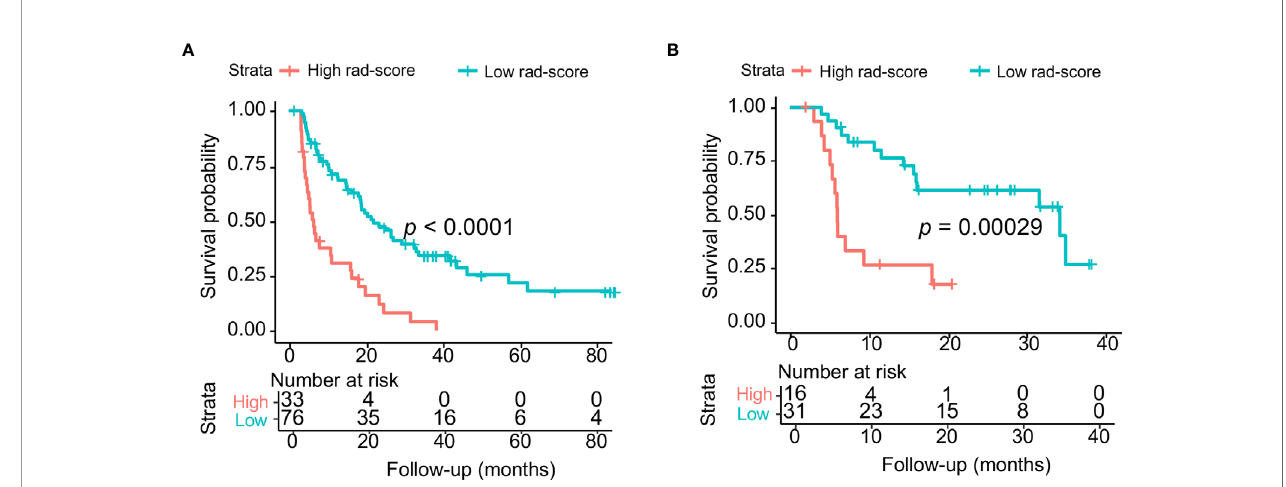
FIGURE 3 | (A) Kaplan – Meier survival curves for the high and low rad-score groups in the training cohort. (B) Kaplan – Meier survival curves for the high and low rad-score groups in the validation cohort.